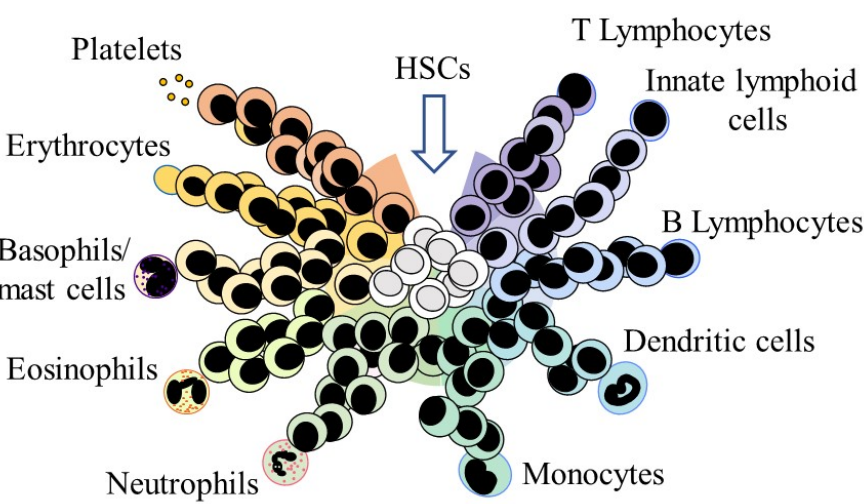
Figure 1. A continuum model for hematopoiesis. Hematopoietic stem cells (HSCs) are a mixture of cells with different lineage signatures, as shown by the different colors for the lineage-affiliated HSCs that are within the colored arc for the HSC compartment. Some HSCs have ‘chosen’ a lineage directly from a spectrum of the end cell options. Even so, they and hematopoietic progenitor cells remain versatile. There are particular close relationships between the cell lineages and HSCs and hematopoietic progenitor cells that have “chosen” a pathway can step left or right into a different pathway to give rise to a different cell type.